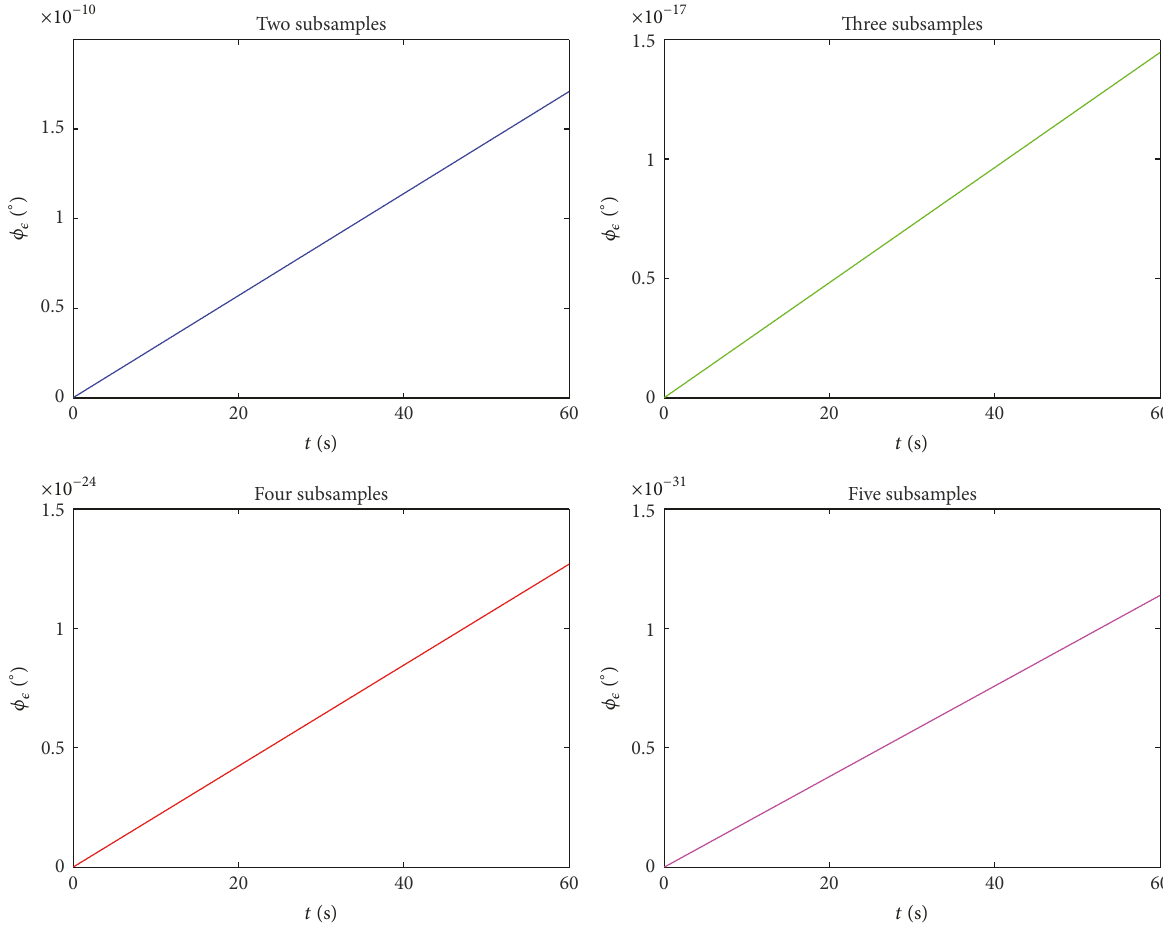
Figure 6: Drifting errors by conventional